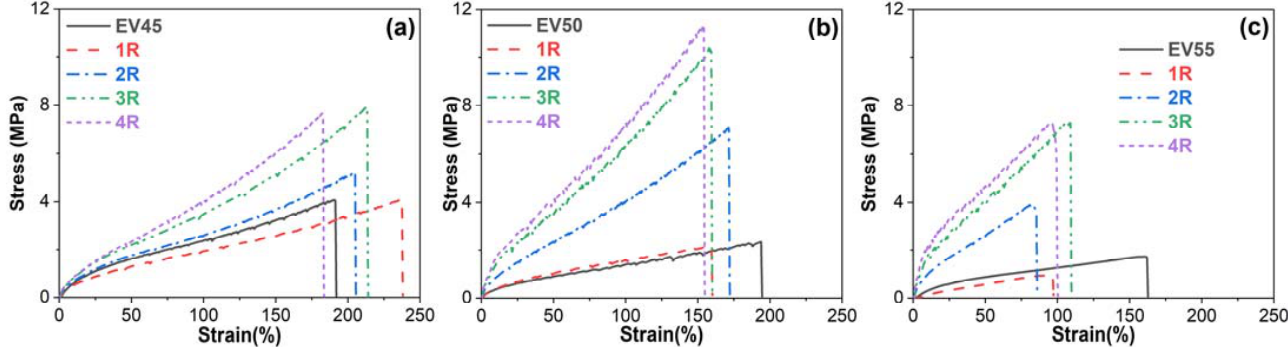
Figure 11. Stress–strain curves of the original and recycled epoxy vitrimers: ( a ) EV45, ( b ) EV50 and ( c ) EV55. ( c )